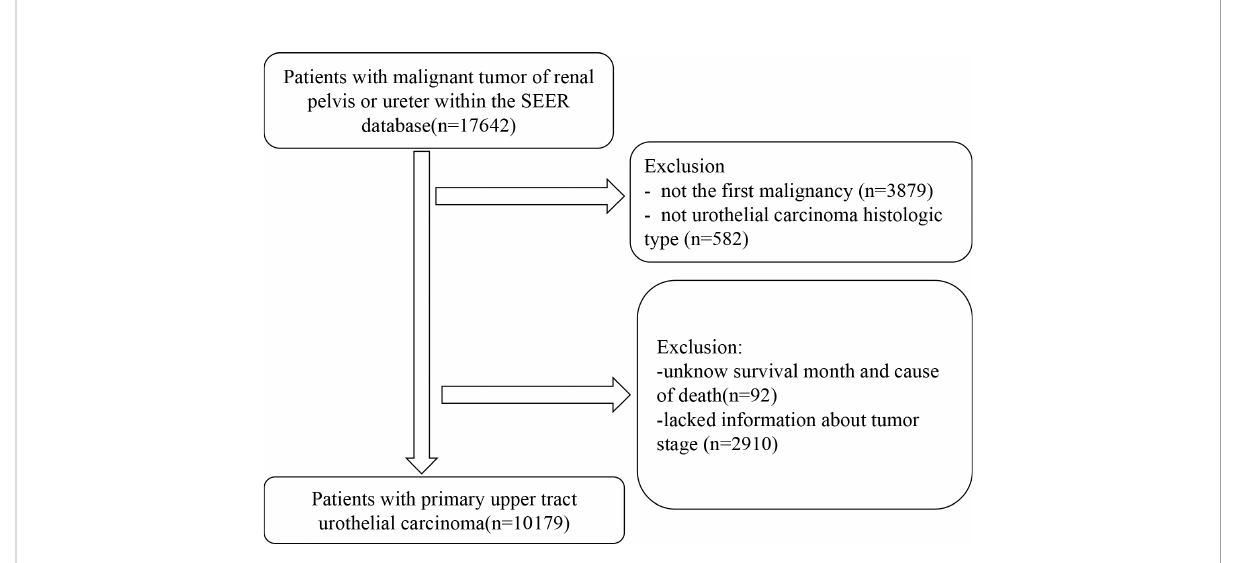
FIGURE 1 Flow chart of the participants ’